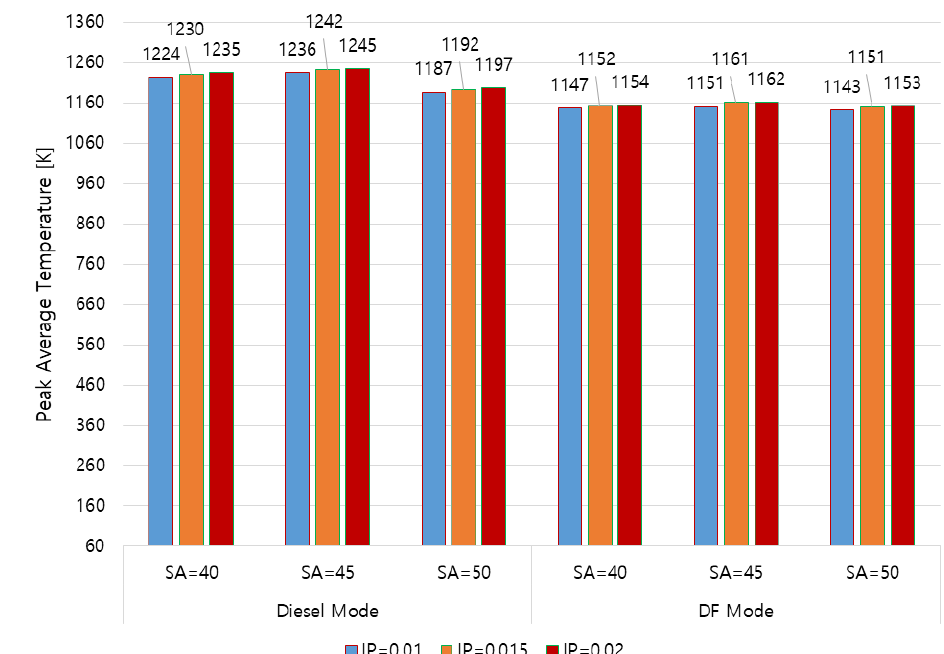
Figure 13. In-cylinder peak average temperatures in all simulation cases.